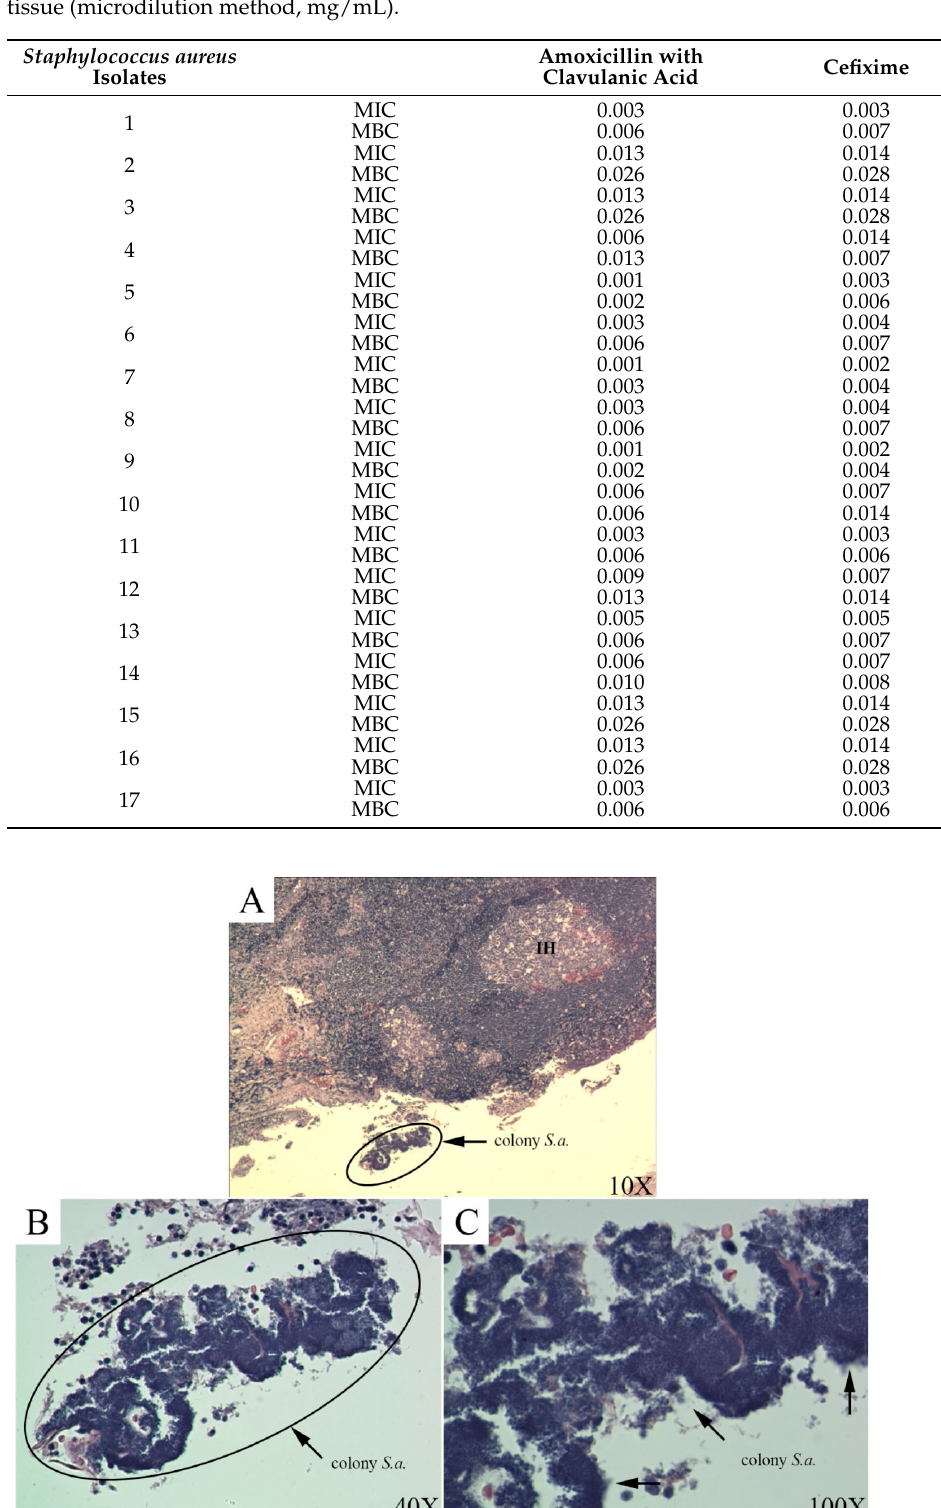
Table 6. Antibiotic susceptibility among Staphylococcus aureus isolates from palatine and adenoid tissue (microdilution method, mg/mL).